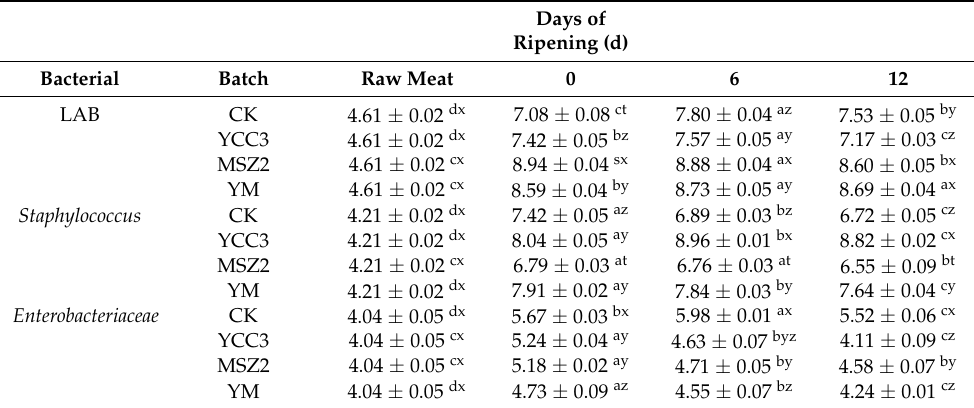
Table 3. Counts of LAB, Staphylococcus , and Enterobacteriaceae (log CFU/g) in fermented sausage during ripening